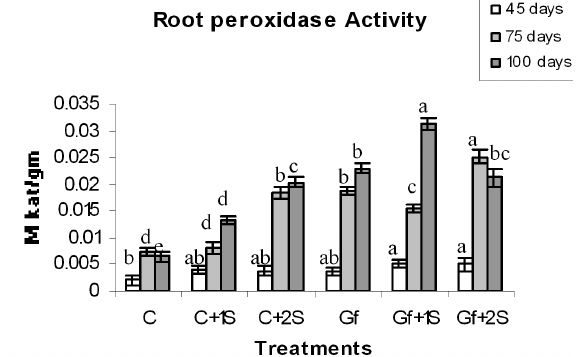
Fig. 6. Shoot peroxidase activity in Gmelina arborea Roxb inoc- ulated with Glomus fasciculatum after 45, 75 and 100 days after AM inoculation